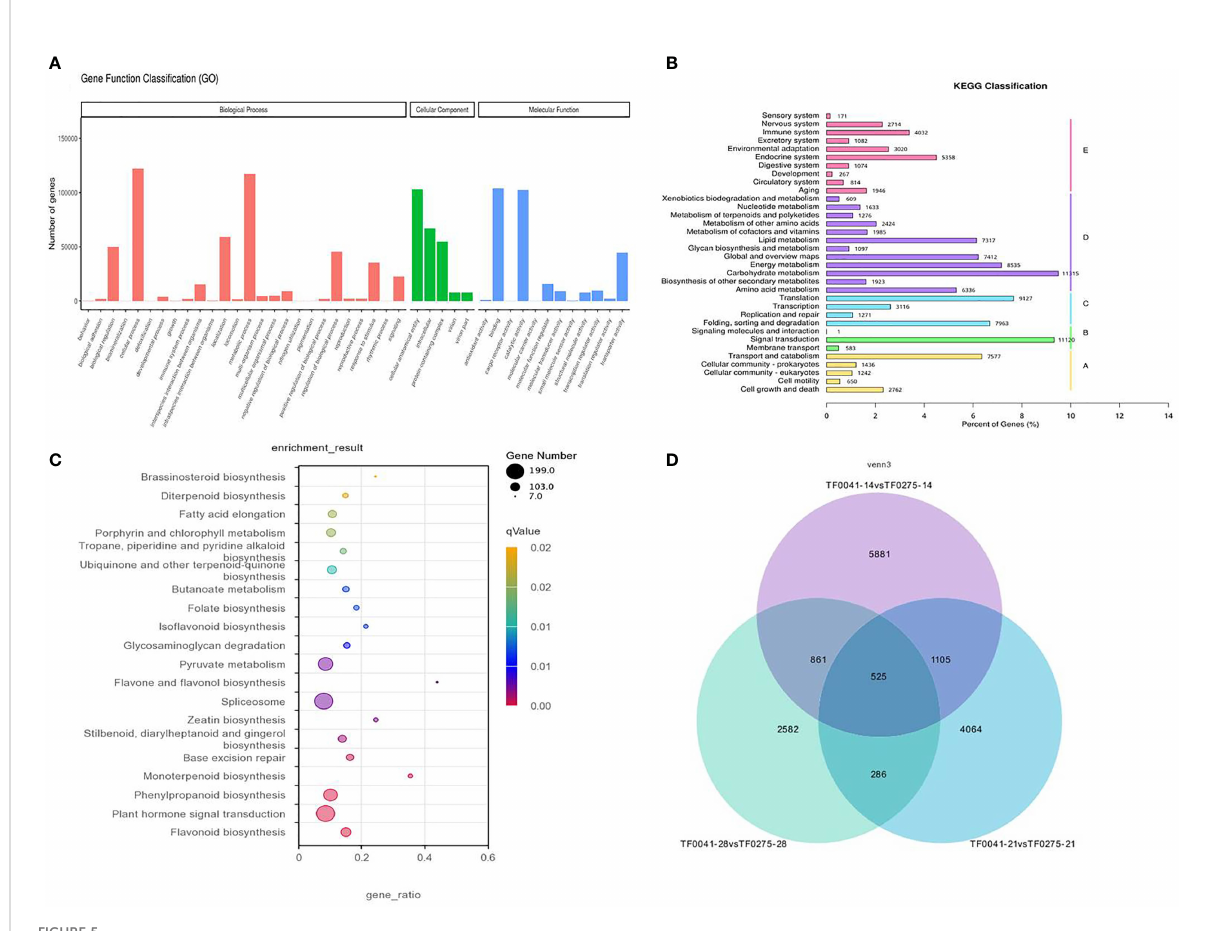
FIGURE 5 Classi fi cation of the assembled transcripts and the differentially expressed genes (DEGs). (A) Gene Ontology (GO) classi fi cation of the assembled transcripts. (B) Kyoto Encyclopedia of Genes and Genomes (KEGG) classi fi cation of the assembled transcripts. (C) KEGG classi fi cation of the DEGs. (D) Venn diagram representing the number of DEGs consistently present in the three